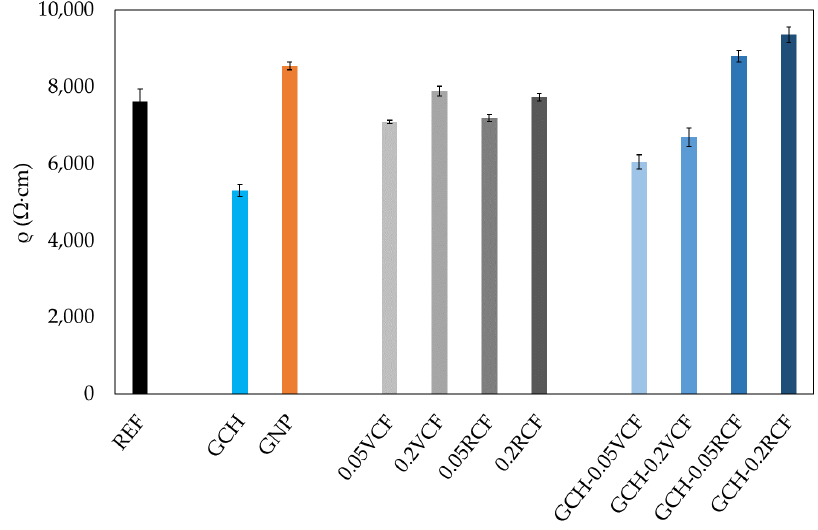
Figure 9. Electrical resistivity ( ρ ) of mortars after 28 days of curing measured in DC.